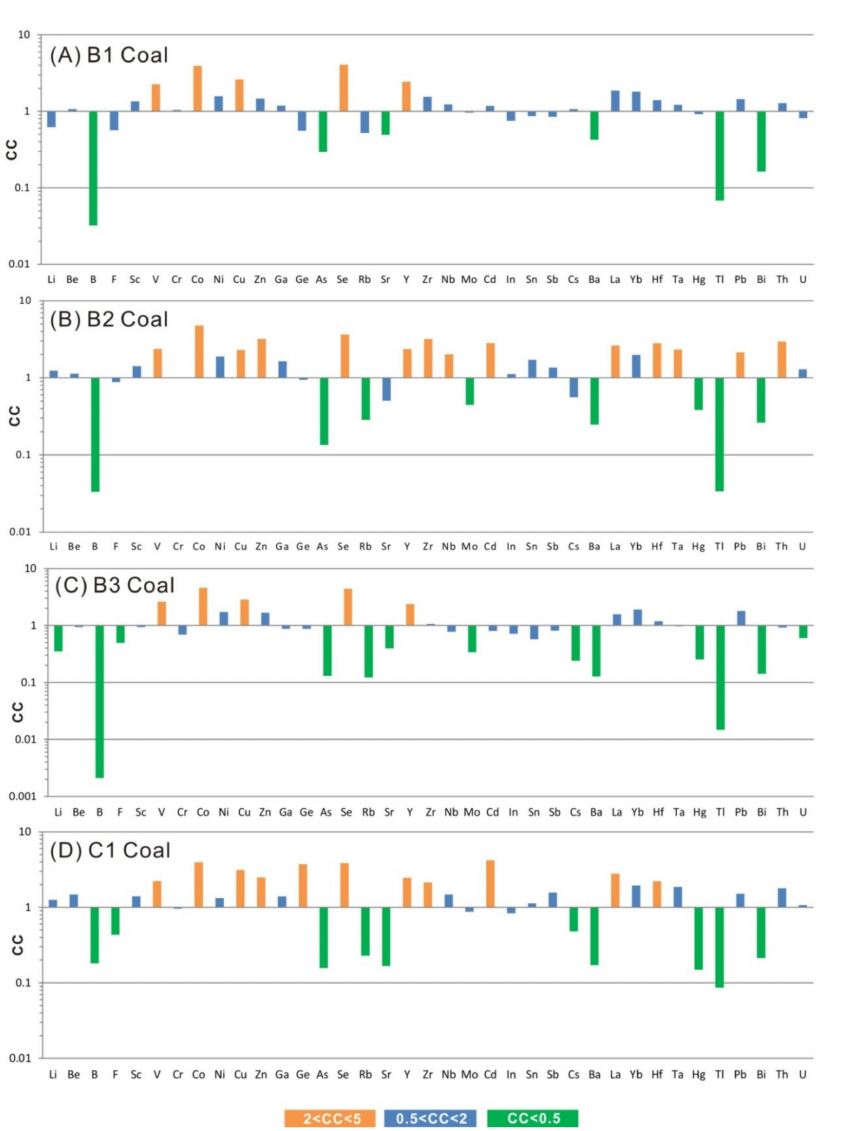
Figure 19. Concentration coefficients (CC) of trace elements in the Bole and Laibin coals, normalized to average trace element concentrations of world hard coals from Ketris and Yudovich (2009) [77]. ( A ), B1 Coal; ( B ), B2 Coal; ( C ), B3 Coal; ( D ), C1